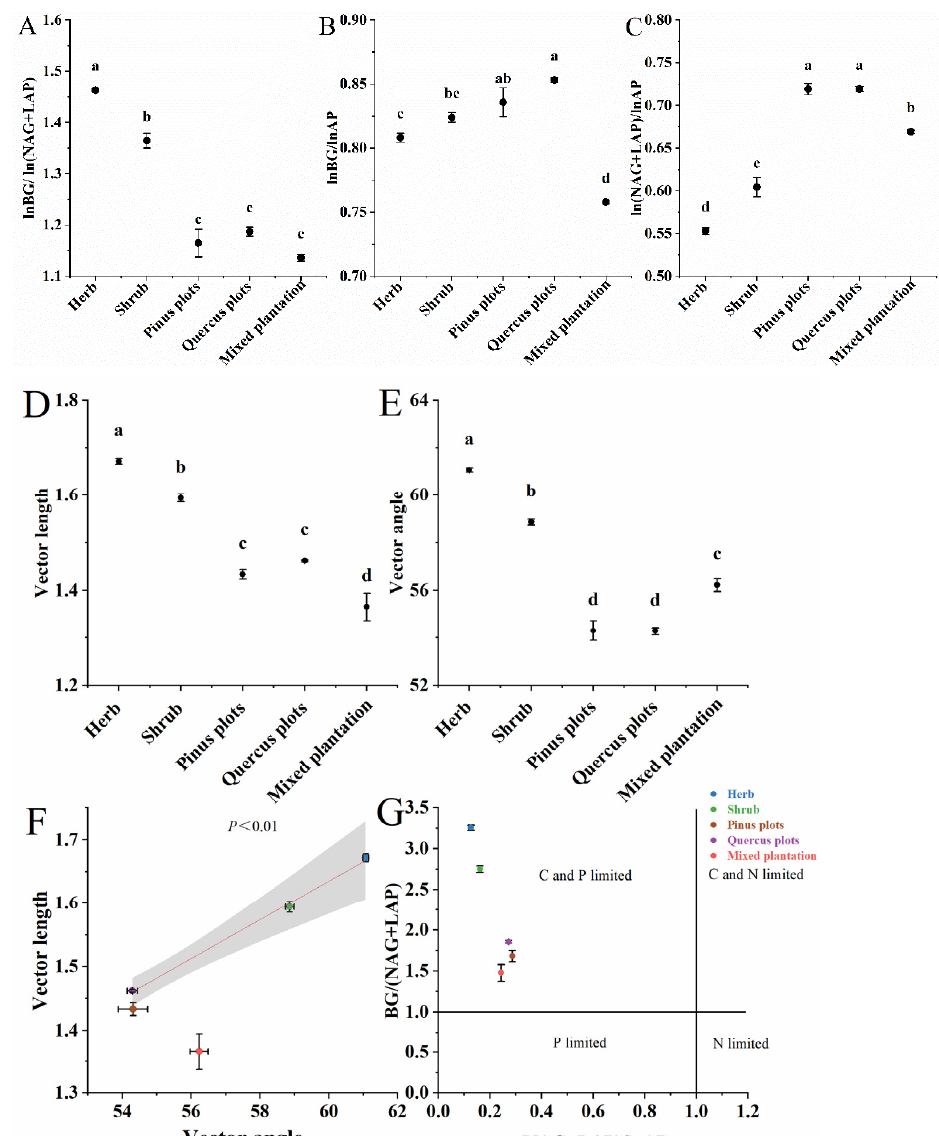
Figure 3. Extracellular enzyme stoichiometry of the relative proportions, ( A – E ) Changes in extracellular enzyme stoichiometry, vector length, and vector angle were calculated according to the ratios of the log-transformed BG, NAG + LAP, and AP. ( F ) Linear regression analysis to identify the relationships of microbial C limitation with microbial N or P limitation. Longer vector length indicates greater C limitation. A vector angle of <45° denotes N limitation; angles >45° denote P limitation. ( G ) Stoichiometric analysis of soil enzyme activities to identify potential P and N limita- tions in soil: by using 1 as a horizontal and vertical baseline along the axis of enzyme activity ratios ((NAG + LAP)/AP as the x -axis and BG/(NAG + LAP) as the y -axis), four quadrants representing microbial resource limitations (N limitation, P limitation, C and P limitations, and N and P limitations) were categorized. The different letters indicate significant differences between treatments according to the Tukey test; lowercase letters (such as a, b, c, d) indicate significant differences ( p < 0.05) among the five sampling